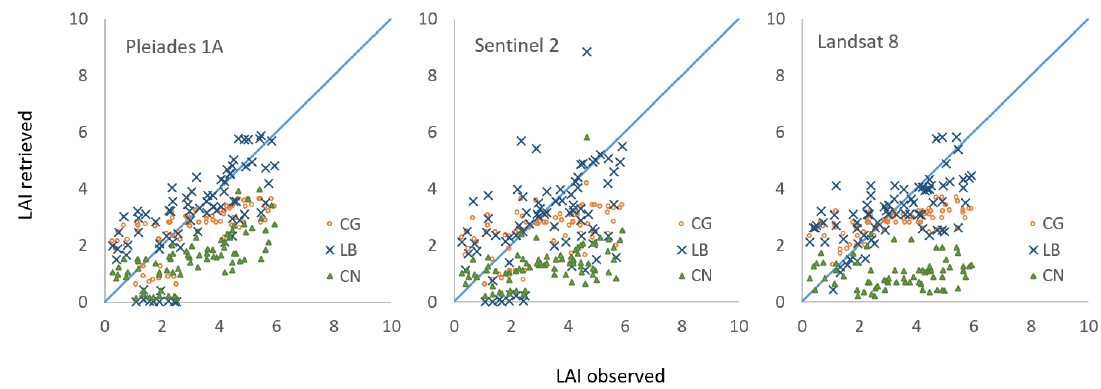
Figure 4. Scatterplots of observed vs. retrieved LAI from remote sensing data. The blue line represents the 1:1 line.